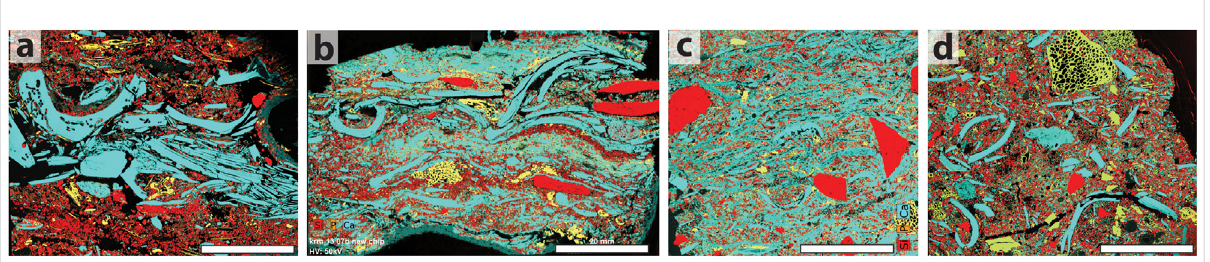
FIGURE 10 Fabric analysis of middens using compositional maps showing the distribution of the elements Ca, P and Si. In these images, shell, ash and secondary carbonate areblue;sand andquartzite arered,and bonesareyellow. All images arethesamescale; thescale baris2 mm. (A) LSAmidden in Cave 1 (sample KRM-13-25) showing a discrete layer composed only of shell debris in between two layers rich in quartz sand with inclusions of bone. Several of the larger shells contain tubular pores that form as a result of invertebrate boring. Shell fragments are roughly horizontally aligned. (B) MSA I midden in the LBS deposits of Cave 1 (sample KRM-13-07) showing multiple discrete layers containing more than 50% shell interbeddedwithlensesofsand,mixeddebrislayerscontainingquartzite,shell,sandandbone,andlayersofash.Shell,quartziteandbonefragments are roughly horizontally aligned. Many of the shells are fragmented in place. (C) MSA I midden in the LBS deposits where the Cave 1 and Cave 1a depositsconnect(sampleKRM-13-01)showingnodiscretelayers.Shellsareroughlyhorizontallyalignedandembeddedinsecondarycarbonateand ashes, yet still comprise greater than 50% of the deposit. In this sample, there are as many as eight shells per cm of thickness, which indicates signi fi cant post-depositional compression. Quartz sand is mixed throughout and the large fragments of quartzite debitage have random orientations. Under the microscope, fragments of charcoal and recrystallized ashes are also randomly mixed. This type of midden is interpreted as a reworked version of (B) . (D) HP midden in Cave 1a (sample KRM-13-13) that is rich in shell ( < 50%), but is not classi fi ed as a shell midden. Here all materials including the shell fragments have random orientations, suggesting that these materials were scooped up from their original place of deposition and dumped